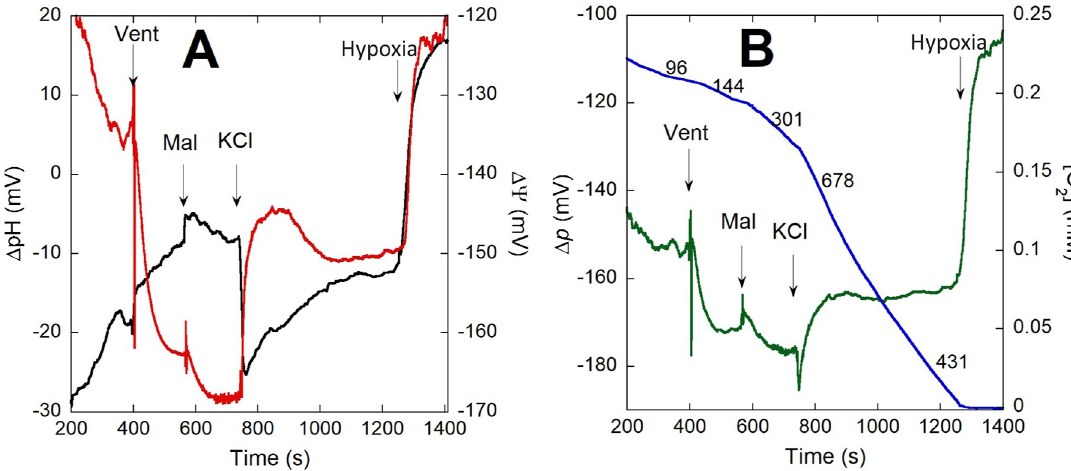
Fig 6. Simultaneous determination of Δ pH and Δ C to calculate Δ p as a function of respiration rate in the presence of venturicidin. 2 x 10 9 K + -depleted cells/ml expressing 3 copies of pH-sensitive GFP were incubated in depletion buffer in the presence of 10 μ M venturicidin (Vent) for 3 min before 16.5 mM sodium malate (Mal) was added at the indicated time point followed by 10 mM KCl. In panel A, Δ pH (black) and Δ C (red) were determined as described in Methods to calculate Δ p (green), shown in panel B overlayed with the O 2 concentration trace (blue) showing respiration rates recorded after the indicated